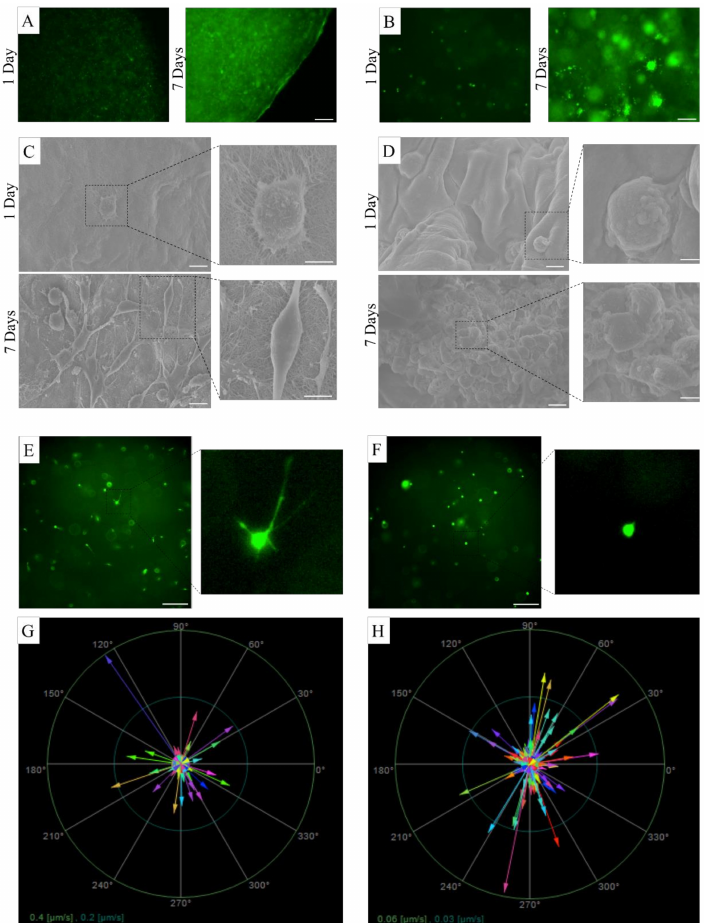
Figure 5. Behavior of individual glioblastoma type IV cells in hydrogels. ( A , B ) Fluorescent microscopy images of U87-MG GFP + cells at days 1 and 7 post inclusion in COL and HA, respectively. Increase in fluorescent intensity indicates cell proliferation (scale bar = 100 µ m). ( C , D ) SEM images of U87-MG cells at days 1 and 7 post inclusion in COL and HA, respectively. High magnification micrographs, on the right, document the di ff erent cell morphologies: elongated and separated in COL; rounded and clustered in HA (scale bar = 10 µ m). ( E , F ) Fluorescent microscopy images of U87-MG cells included in COL and HA, respectively. High magnification images, on the right, confirm elongated morphologies for COL and rounded shapes for HA (scale bar = 100 µ m). ( G , H ) Polar diagrams representing cell mobility behavior of U87-MG cells included in COL and HA,